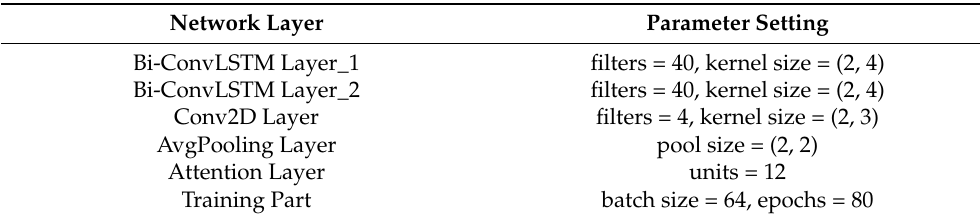
Table 1. Parameters setting table of each part of Bi-ConvLSTM-CA